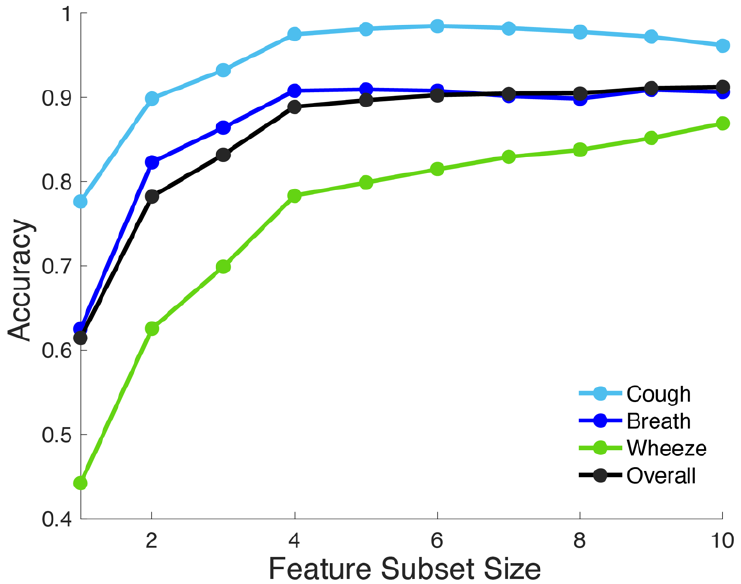
Figure 3. Classification accuracy of the proposed K-MDC while increasing number of features from k = 1 until 10 .